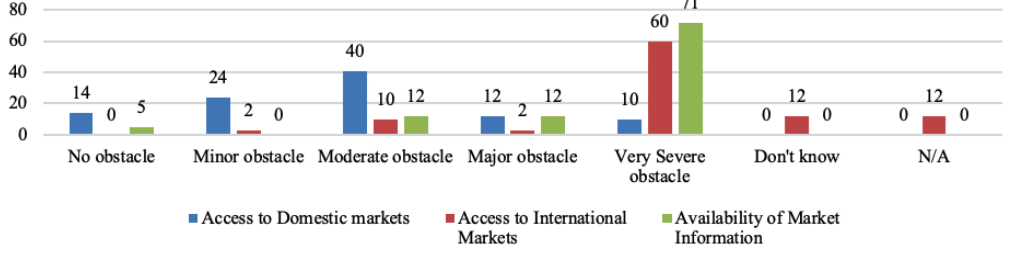
Figure 4: Elements of the market